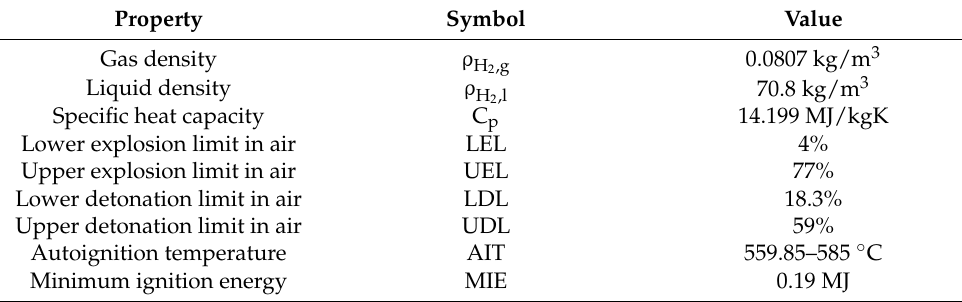
Table 3. Physical properties of hydrogen [113–119].